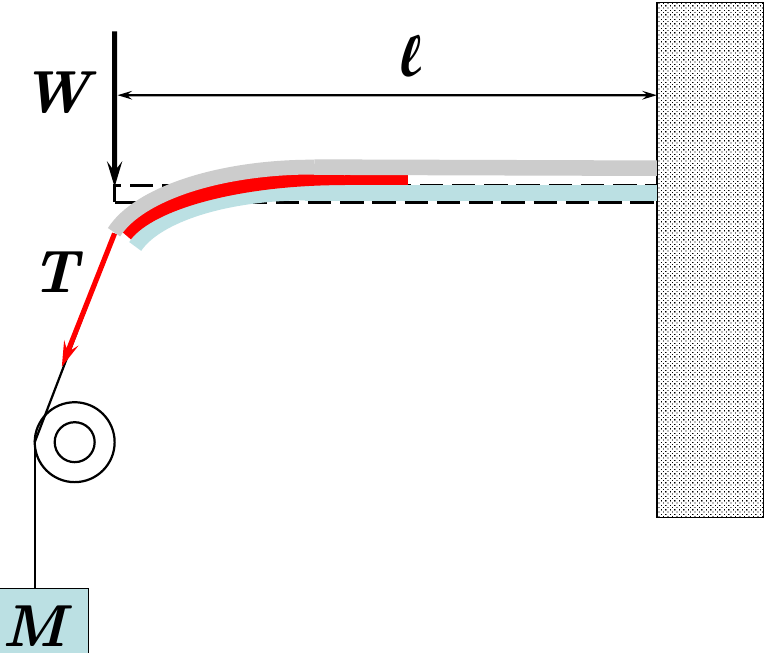
Figure 19. Schematic of the apparatus in Figure